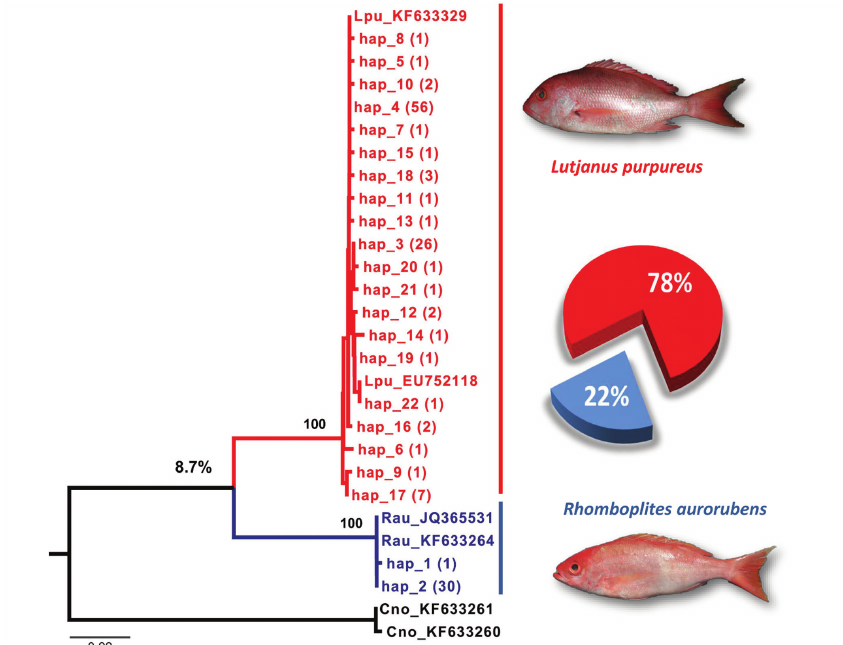
Fig. 1. Neighbor-joining (NJ) tree constructed from a 600-bp of the COI gene, showing two clades, which indicates the presence of two species among the fillets labeled as “Pargo”; the nucleotide divergence between the species (the value of 8.7%) is indicated above the outermost node. Within parentheses the frequency of each haplotype is described and the replacement rate present in the fillets is shown in plot to the